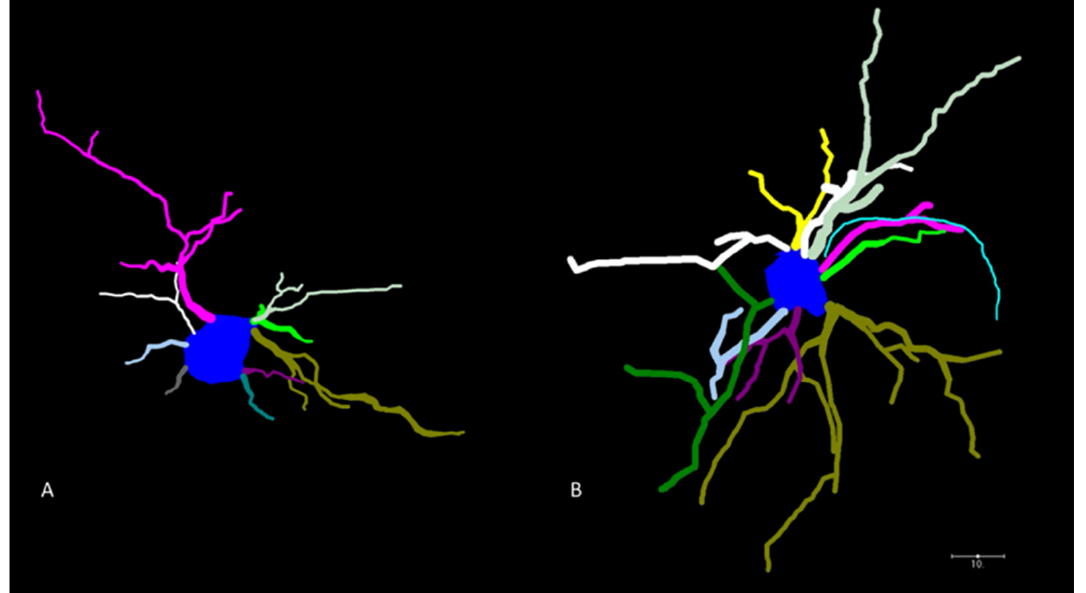
Figure 1. Golgi-stained MSNs in the caudate/putamen. Representative Neurolucida tracing of medium spiny neurons from a saline-treated animal ( A ) and an ethanol-treated animal ( B ), demon- strating the difference in observed branch patterns at 24 h. The scale bar in the bottom right corner of the image represents 10 μ m.